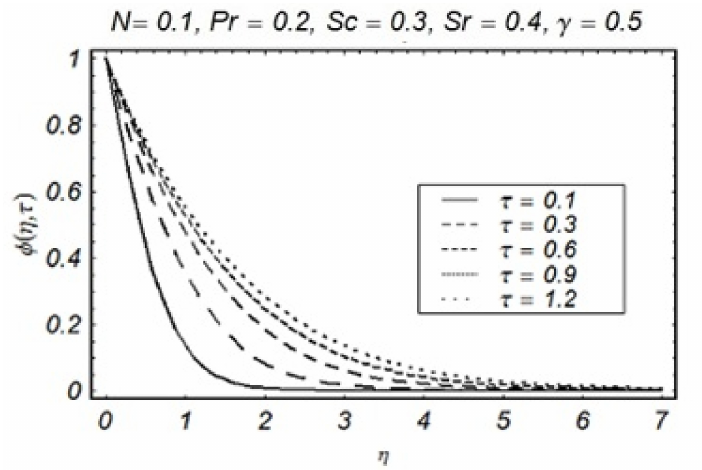
Figure 13. Indication of τ on solute profile.